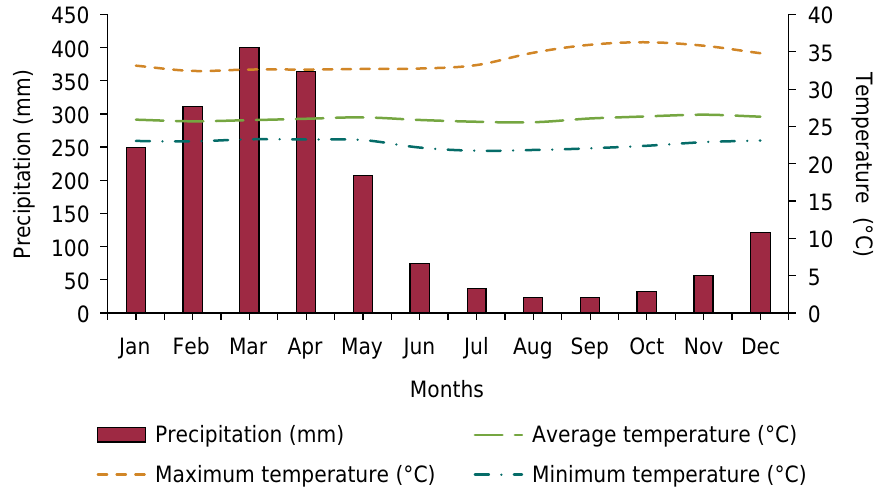
Figure 1. Monthly averages of historical temperature data (1973 - 2019) and rainfall (2004-2018) for the Pindaré-Mirim region obtained from the National Water Agency and the National Institute of Meteorology,